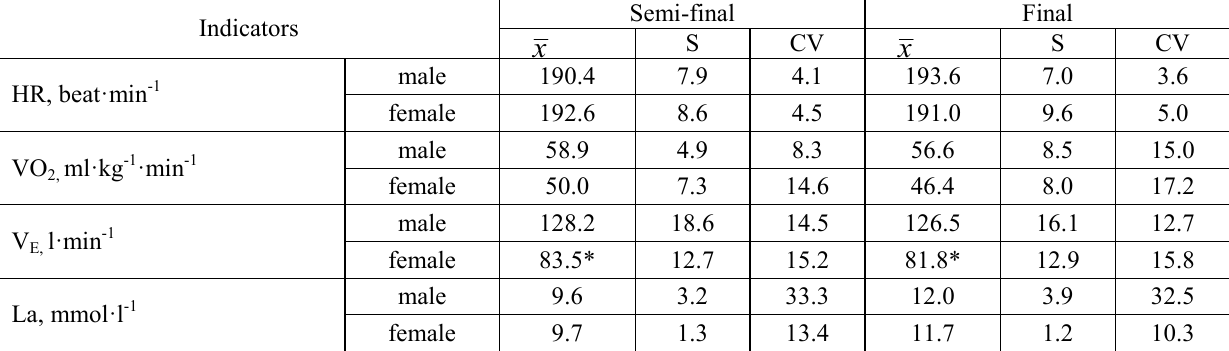
Differences between characteristics of physical fitness в 12 couples